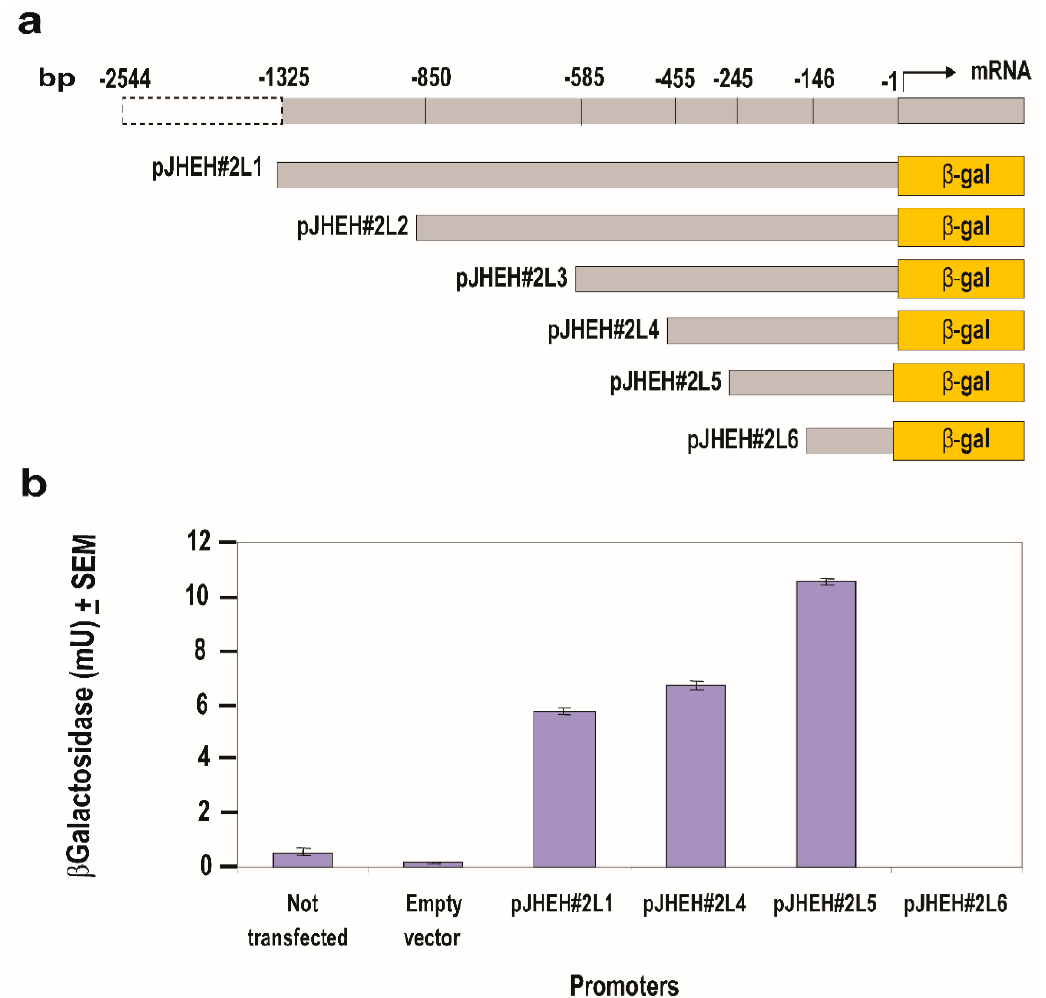
Figure 6. Testing jheh 2 different promoter sequence lengths ( a ) for transcriptional activity ( b ) by cloning them into plasmid pCaSpeR-AUG- β gal, transfecting D.Mel2 cells with the recombinant plasmid and assaying 2 × 10 5 cells for β -galactosidase activity expressed in milliunits (mU). Controls were D.Mel2 cells that were not transfected or transfected with empty plasmid.